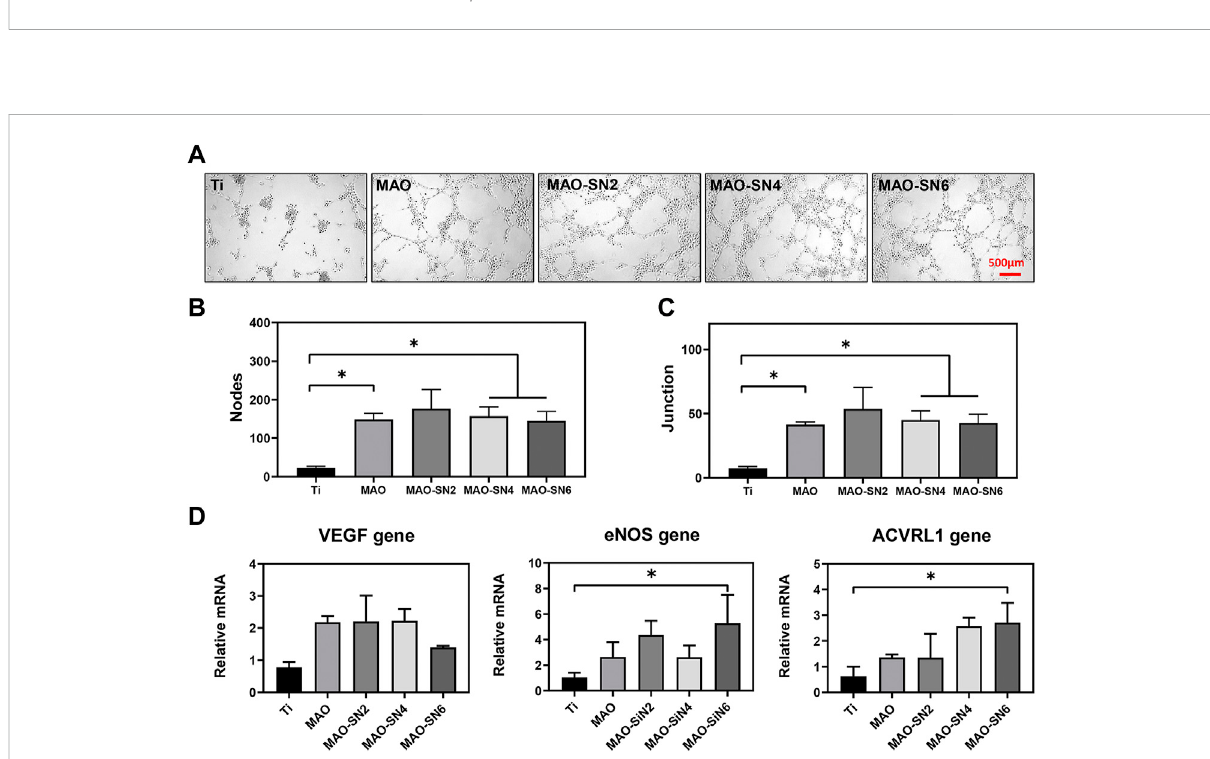
FIGURE 8 (A) Tube formation after 6 h. Quantitative analysis of tube formation according to node (B) and junction (C) numbers. (D) Relative expression levels of VEGF , eNOS , and ACVRL1 by HUVECs after 3 d. * p < 0.05.